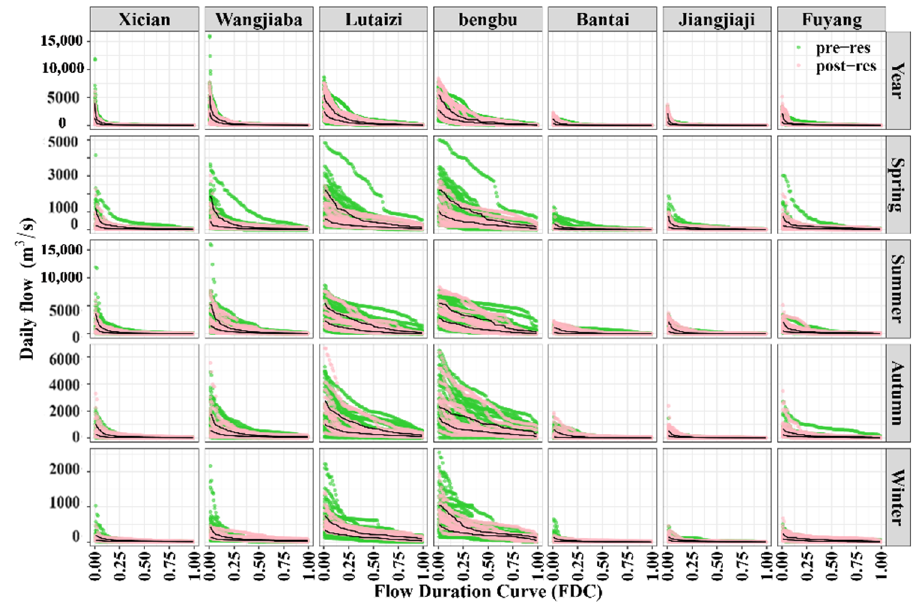
Figure 4. Seasonal and annual FDC before and after change points.